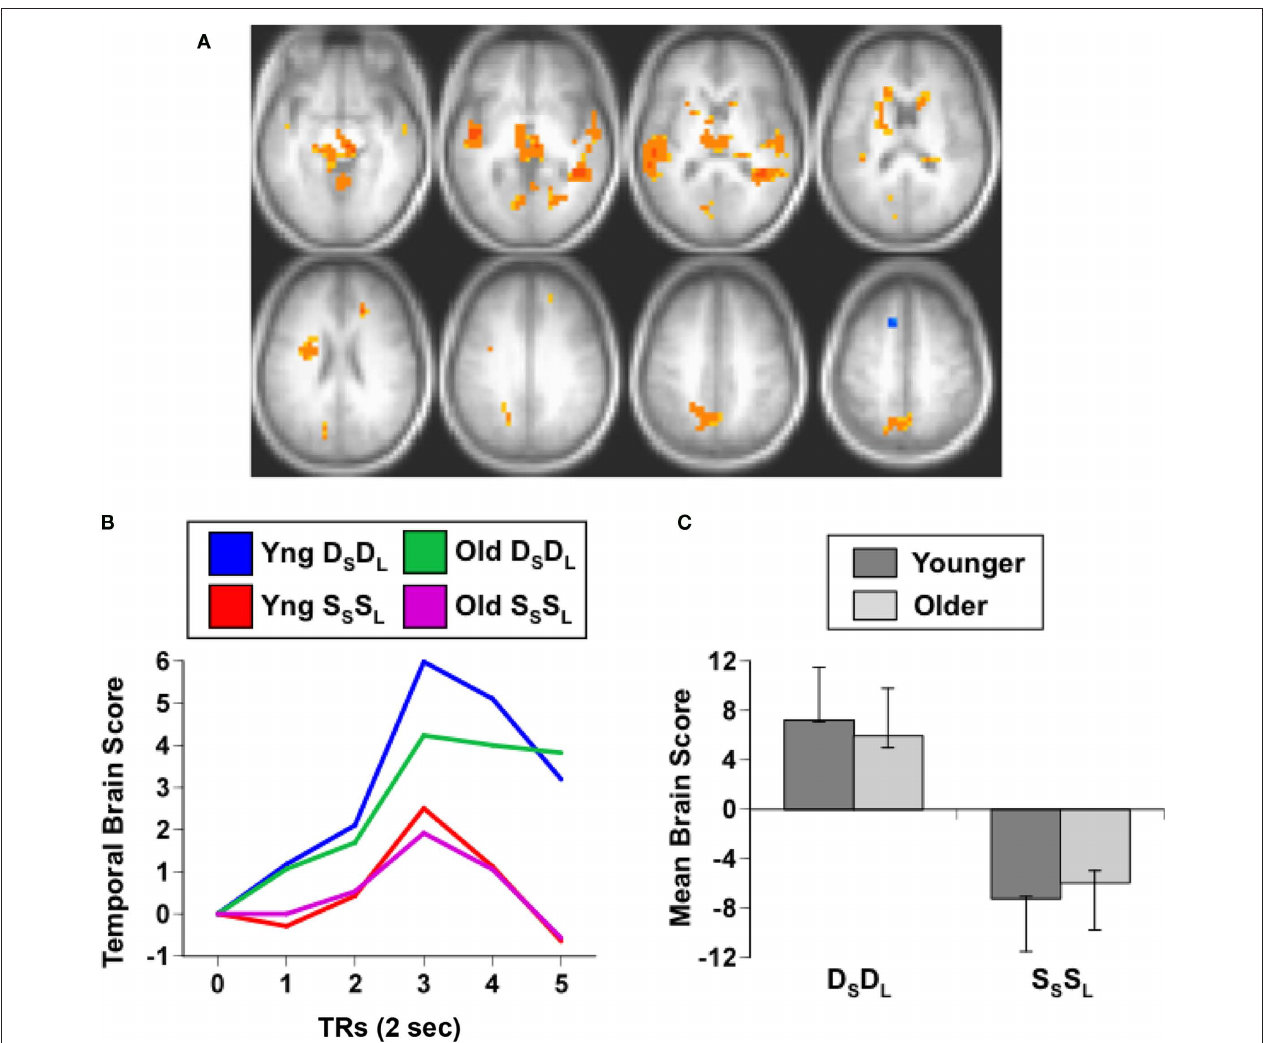
the pattern of brain activity seen in (A) for the two conditions in each age group. D and S S conditions. S L S L (C) Mean brain scores collapsed over all TRs and mean centered (zero in the graph represents overall mean activity). Error bars are the 95% confidence intervals (CIs) calculated from the bootstrap. Non-overlapping CIs across conditions indicate adaptation in S groups within each condition indicates no age differences in activity for either